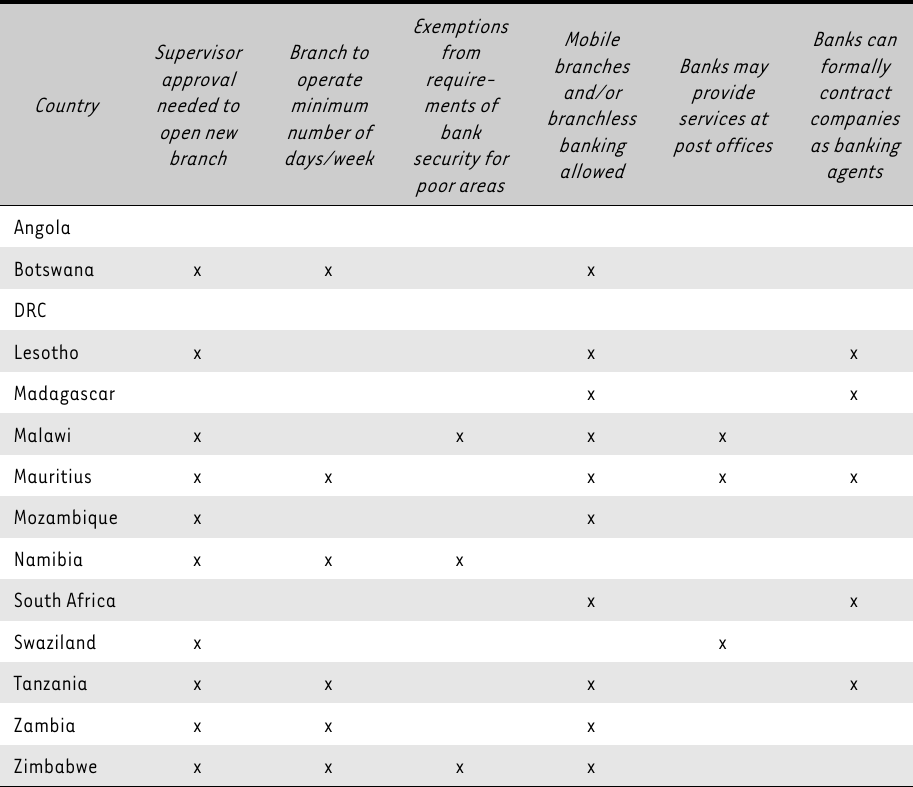
Government policies and regulations regarding bank access points,